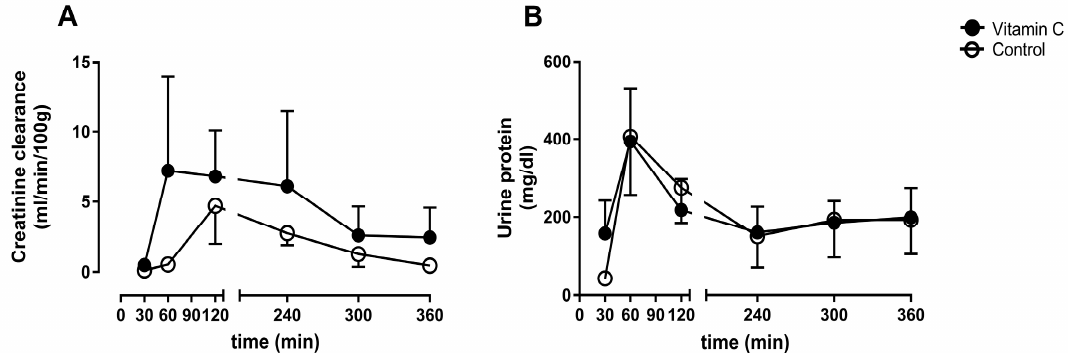
Figure 2. Creatinine clearance rate (A), and concentration of urine protein (B).